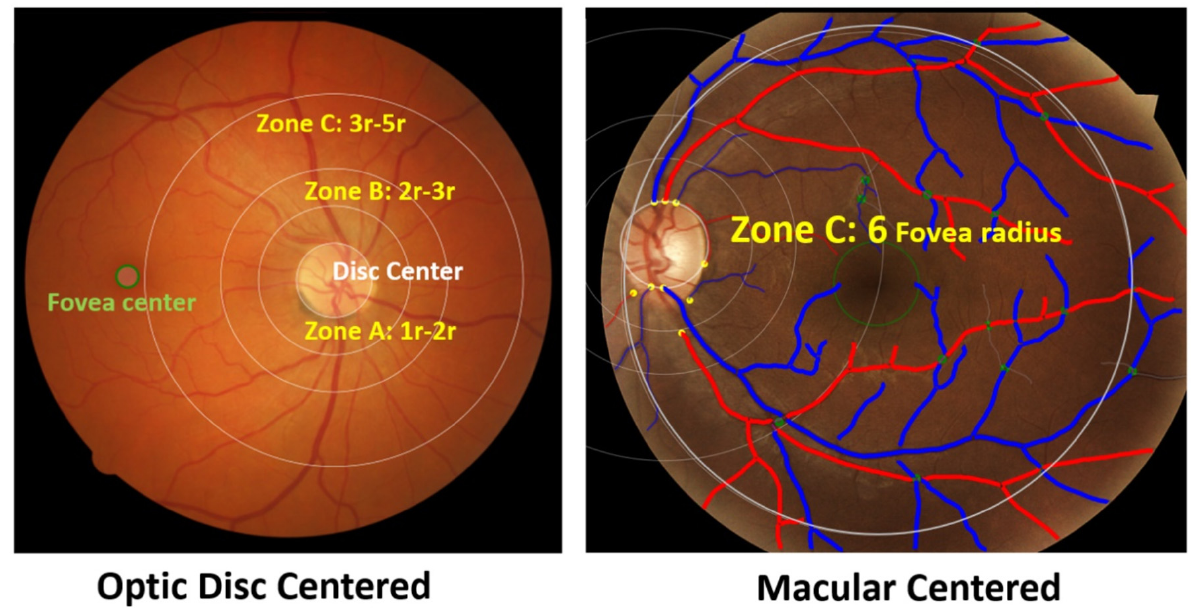
Figure 2. Zones in the retinal photograph. The left figure shows an example optic disc centred image, and the right figure shows an example macular centred image. The right figure also shows vessels classified into arteries and veins. Arteries are shown in red and veins are shown blue.